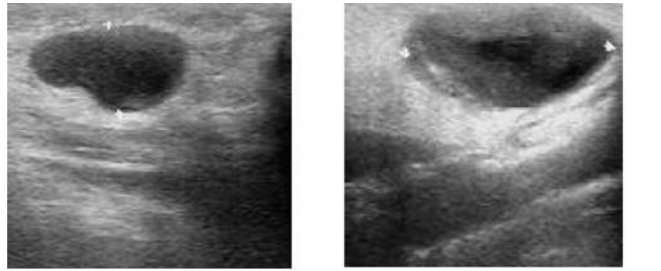
Figure 4. Original ultrasound scanning image.